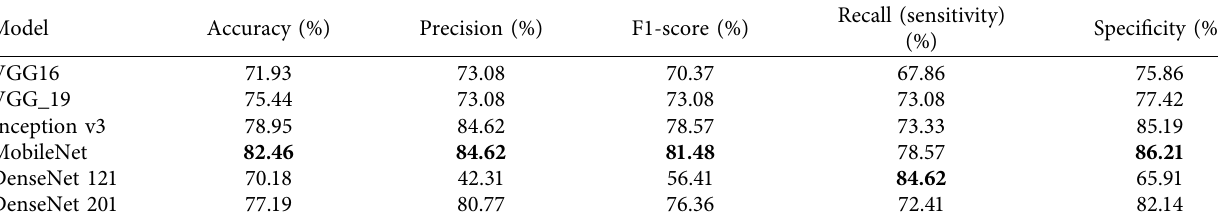
Table 5: Performance for all models in the joint fusion type